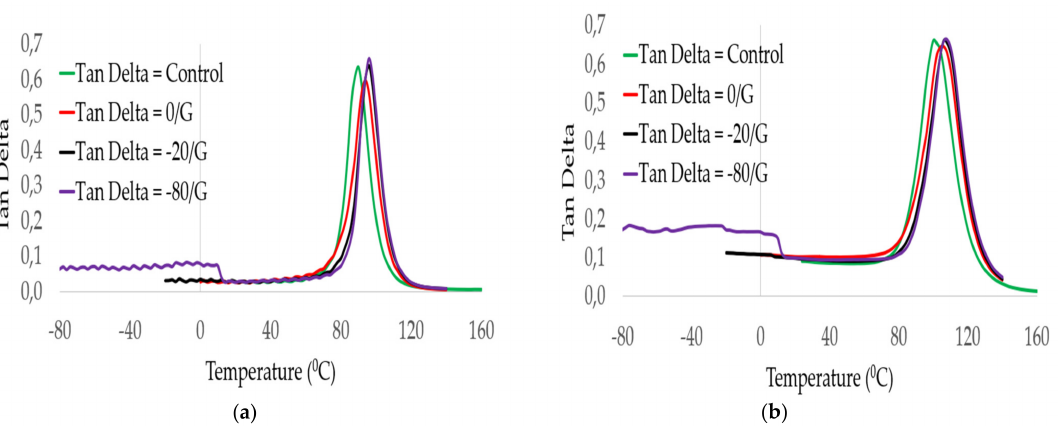
Figure 9. Damping ratio comparisons between GFRP laminates at a frequency ( a ), 1 Hz, ( b ), 100 Hz.